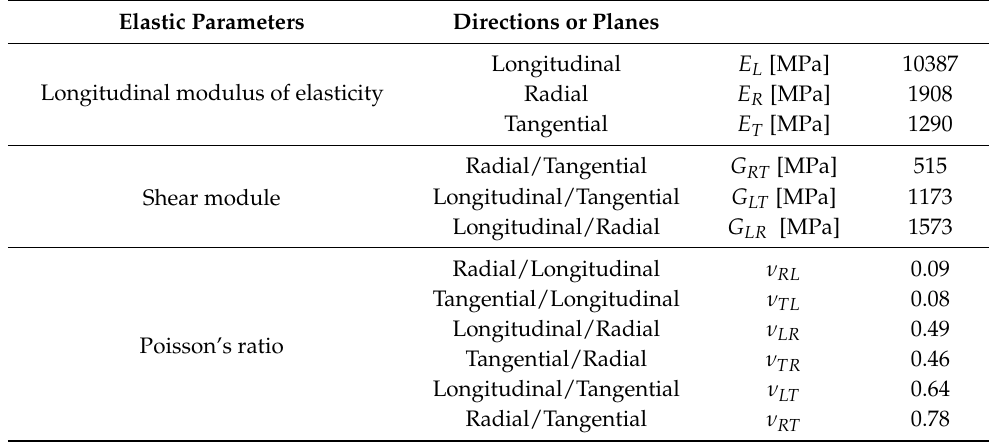
Table 3. Average elastic parameters considered in the numerical simulation. Elastic Parameters Directions or Planes Longitudinal E L [MPa] 10387 Longitudinal modulus of elasticity Radial E R [MPa] 1908 Tangential E T [MPa] 1290 Radial/Tangential G RT [MPa] 515 Longitudinal/Tangential G LT [MPa] 1173 Shear module Longitudinal/Radial G LR [MPa] 1573 Radial/Longitudinal ν RL 0.09 Tangential/Longitudinal ν TL 0.08 Longitudinal/Radial ν LR 0.49 Poisson’s ratio Tangential/Radial ν TR 0.46 Longitudinal/Tangential ν LT 0.64 Radial/Tangential ν RT